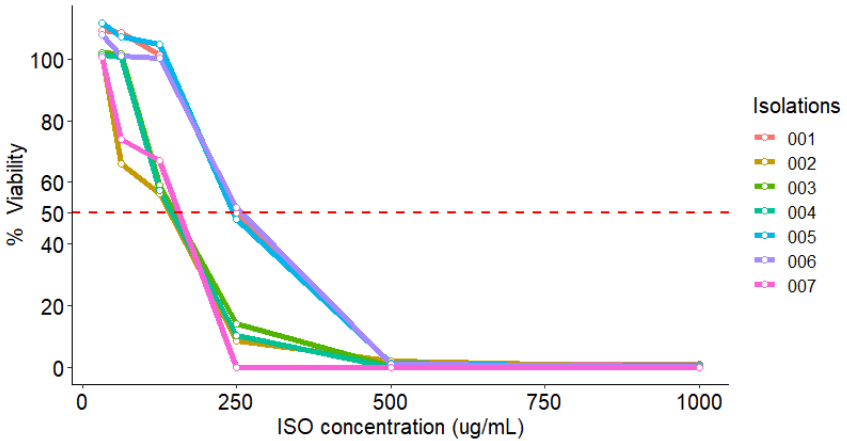
Figure 3. MIC 50 of viability percentage of C. tropicalis isolates exposed to ISO (MIC for each isolate).